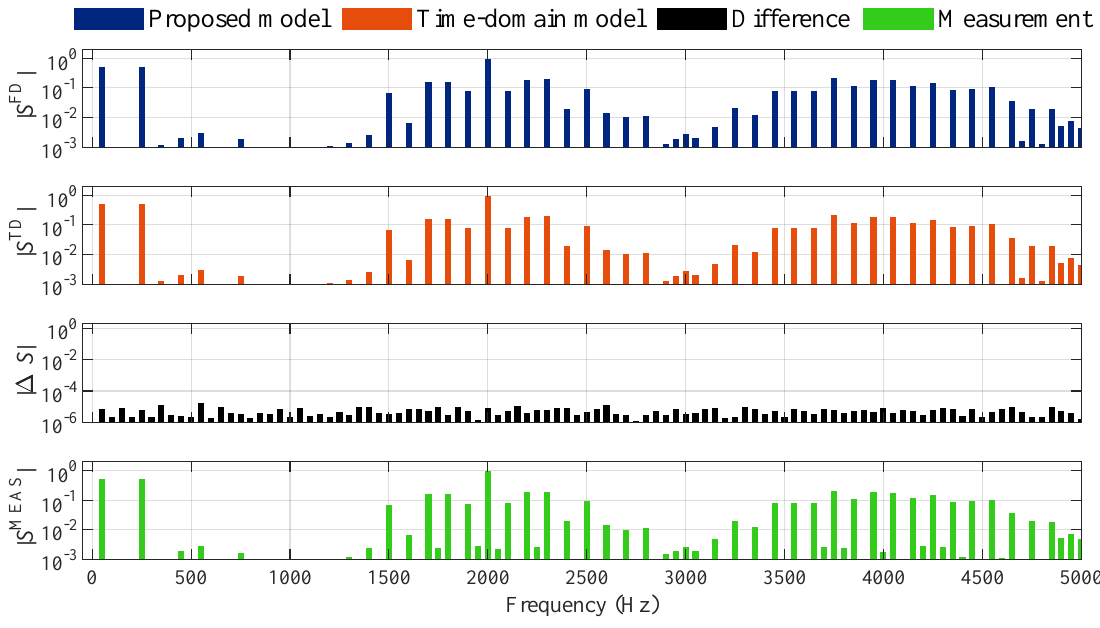
Figure 8. Amplitude spectra of the proposed frequency-domain model (first graph), the time-domain simulation (second graph), their difference based on the complex spectra (third graph), and the amplitude spectra from measurement results (fourth